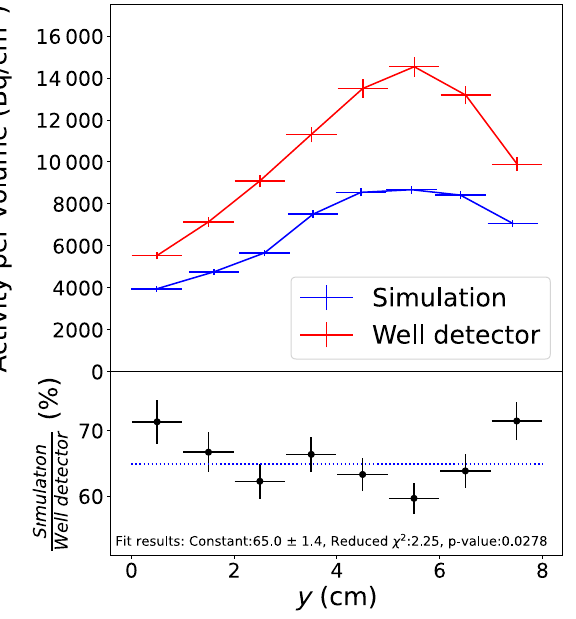
FIG. 13. Comparison of activity measurements and FLUKA simulations for Rod 3b. Refer to the caption of Fig. 12 for details related to the plotting.